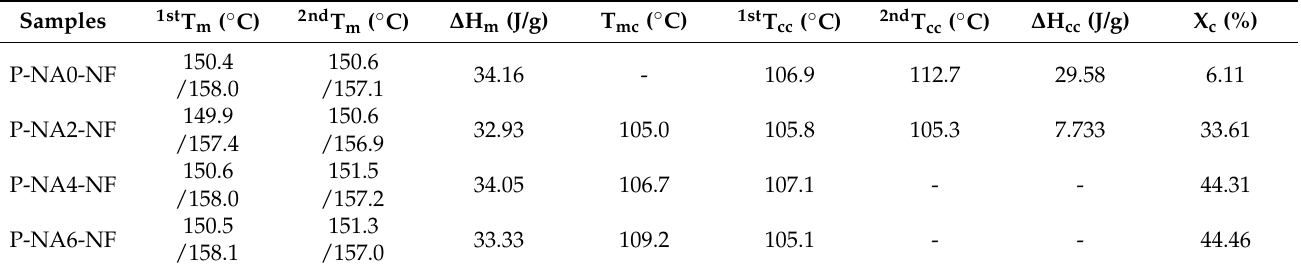
Table 2. Thermal characterization of the NF-reinforced PLA composites with different NA contents.